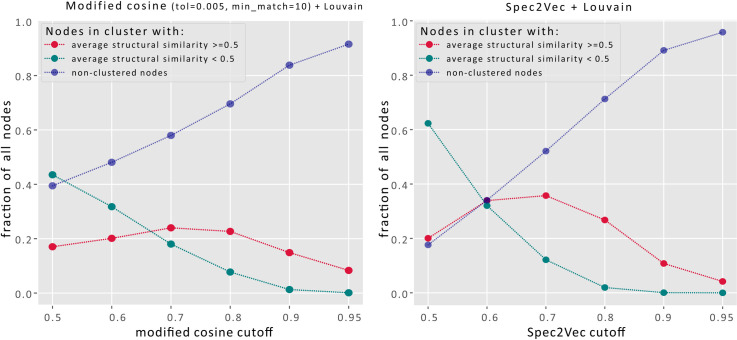
Comparison of spectra clustering using modified cosine (left) or Spec2Vec (right) across a range of similarity score cutoffs.The cluster quality is assessed by measuring the average structural similarity across all linked pairs within each cluster. Setting a structural similarity threshold of 0.5 (see Fig 3A) allows to compare the fraction of spectra that ends up in chemically homogenous clusters (red) with those in more heterogeneous clusters (green) and the fraction of spectra that is not clustered at all (those with no links above set threshold). Clustering is done here by creating edges between spectra (= nodes) for similarities above a certain cutoff (adding max. 10 links per node). To make the resulting clustering more robust and better comparable across different scores, we used the Louvain algorithm to break up the large clusters. Dashed squares mark regions of relatively high retrieval (high fraction of clusters with high structural similarity) and high accuracy (large discrepancy between fraction of high structural similarity and low structural similarity clusters). Overall, Spec2Vec allows to cluster higher fractions of spectra into high structural similarity clusters (> 35% of all spectra are in high similarity clusters for a Spec2Vec similarity threshold of 0.7).